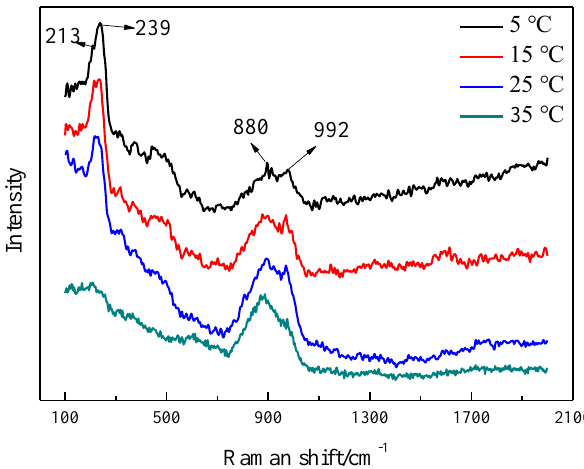
Figure 3. The Raman spectrum of PEO coatings with different electrolyte temperatures.